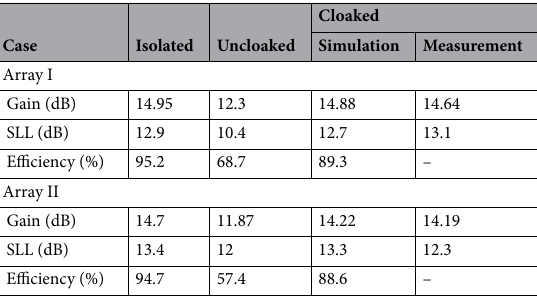
Table 4. Comparison between the radiation characteristics of the arrays in the isolated, uncloaked and cloaked